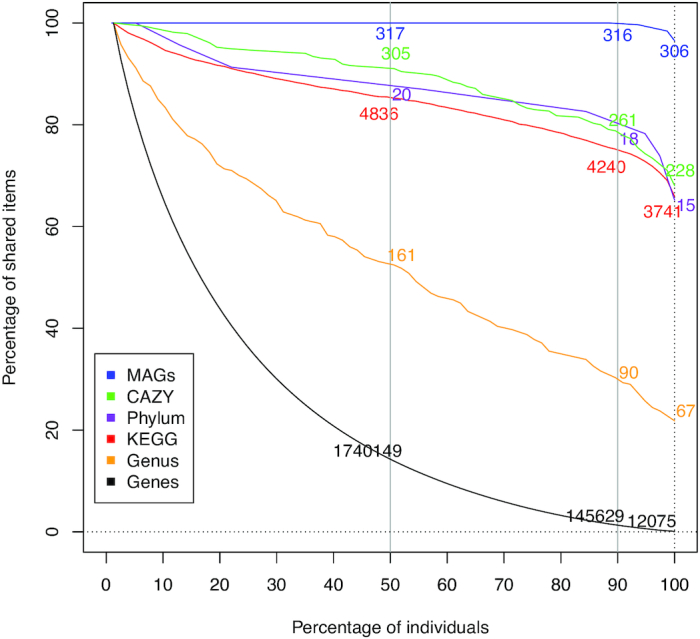
Size of the shared microbiome features among cattle (n = 77) fed 4 different diets for the number of genes, genera, phyla, metagenome-assembled genomes (MAGs), KEGG pathways, and carbohydrate-active enzymes (CAZymes). The percentages of shared items and animals are represented on the y- and x-axes, respectively. The absolute numbers for each item are indicated at the intercept between the percentages of items and animals at the thresholds of 50%, 90%, and 100%. Only ∼1% of genes were shared by 90% of the cattle, whereas close to 80% of KEGG orthologs and CAZy functions were shared by 90% of the cattle, suggesting gene redundancy for similar functions. Note the presence of most MAGs assembled in this work in 90% of the cattle.